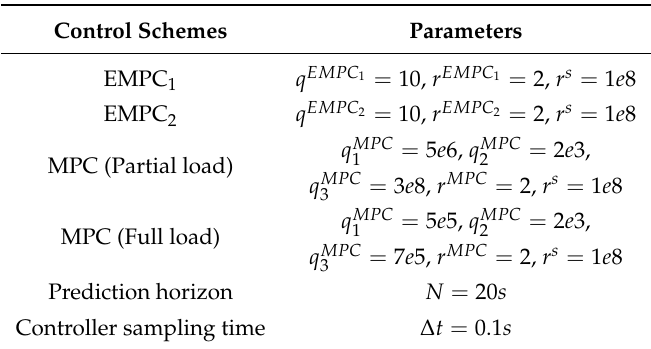
Table 2. Controller